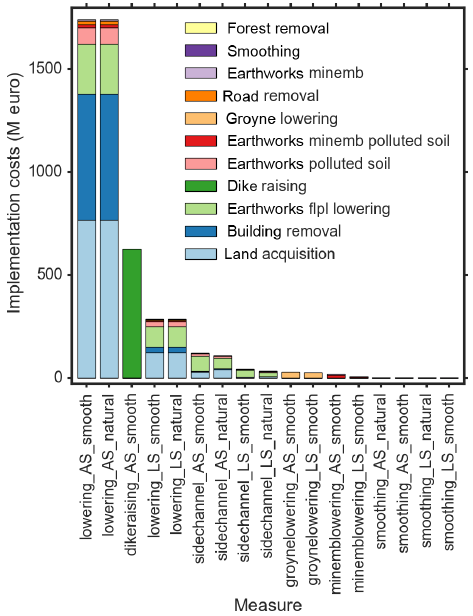
Figure 8. Comparison of costs between scenarios in millions of euro (M